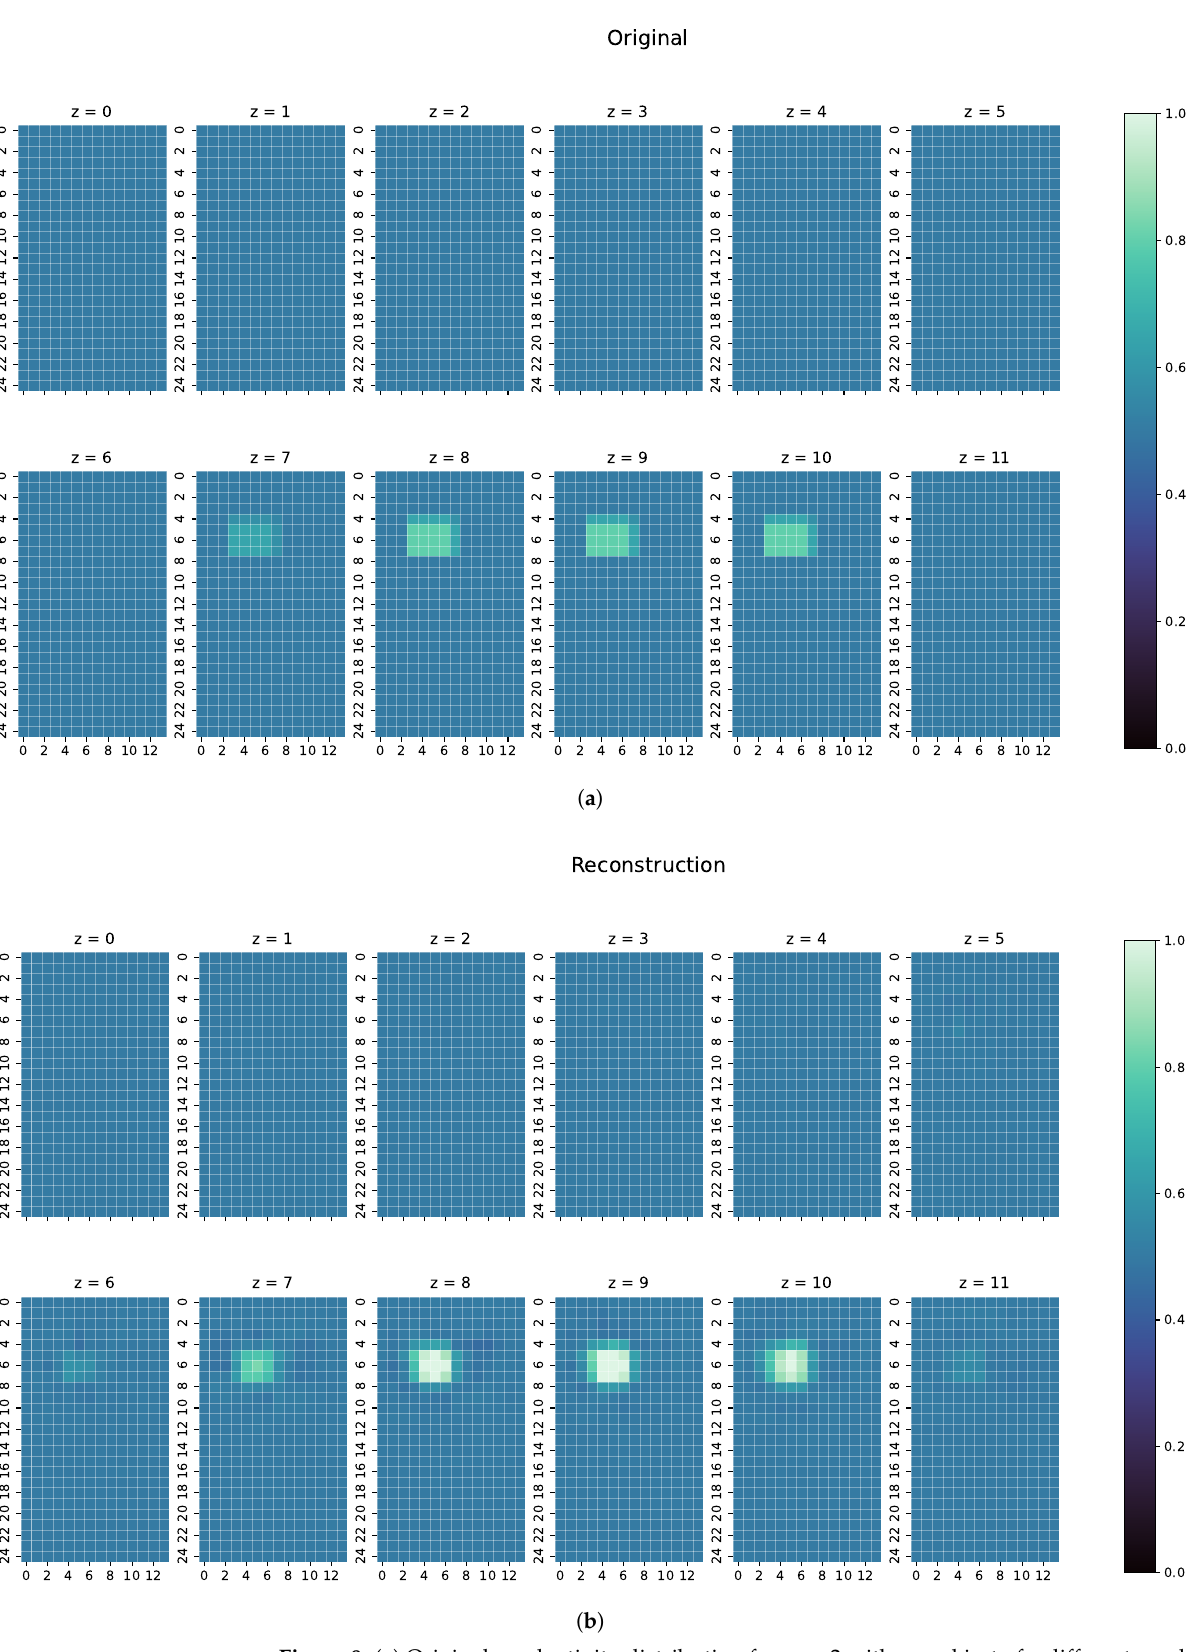
Figure 8. ( a ) Original conductivity distribution for case 2 with one object of a different conductivity than what has been trained. ( b ) Reconstruction of the conductivity distribution of case 2, as shown in ( a